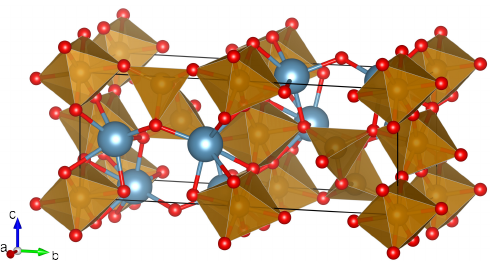
Figure 1. In the unit cell of Ca 2 Fe 2 O 5 , Fe 3 + ions in octahedral and tetrahedral coordination are alternating along the b axis. (Ca 2 + —blue, O 2 − —red)